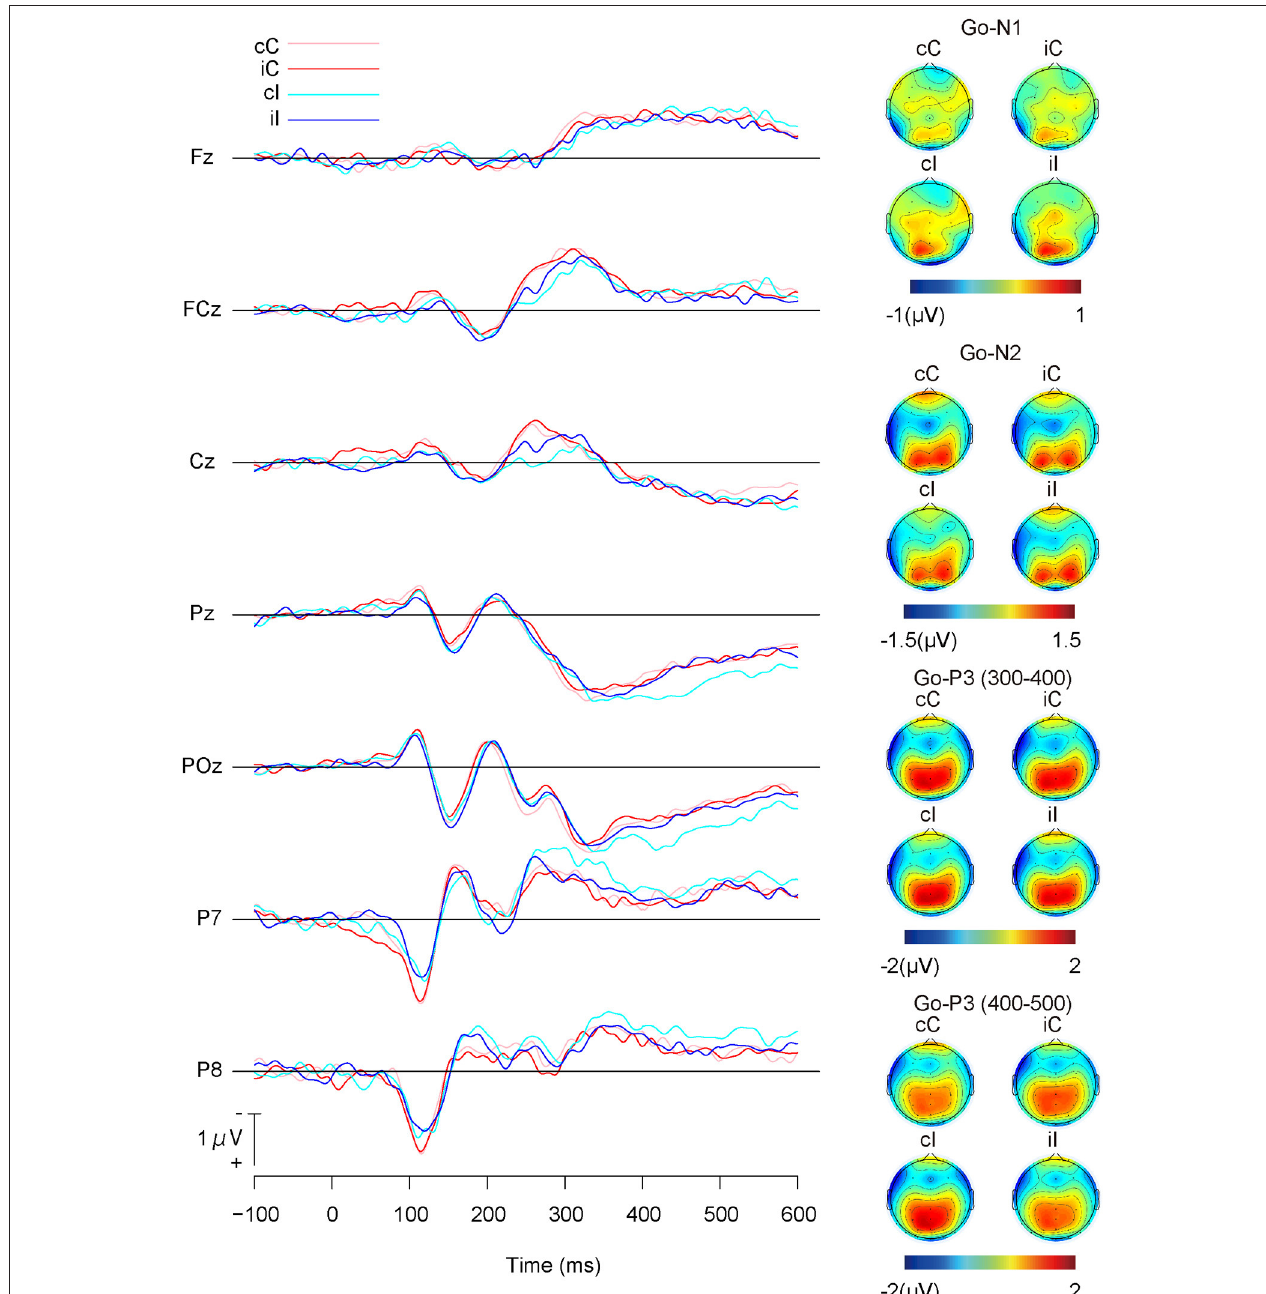
FIGURE 3 | Grand average event-related potential (ERP) waveforms and topographies of Go-stimuli; cC: congruent (the previous trial) → Congruent (the present trial); iC: incongruent → Congruent; cI: congruent → Incongruent; and iI: incongruent → Incongruent.